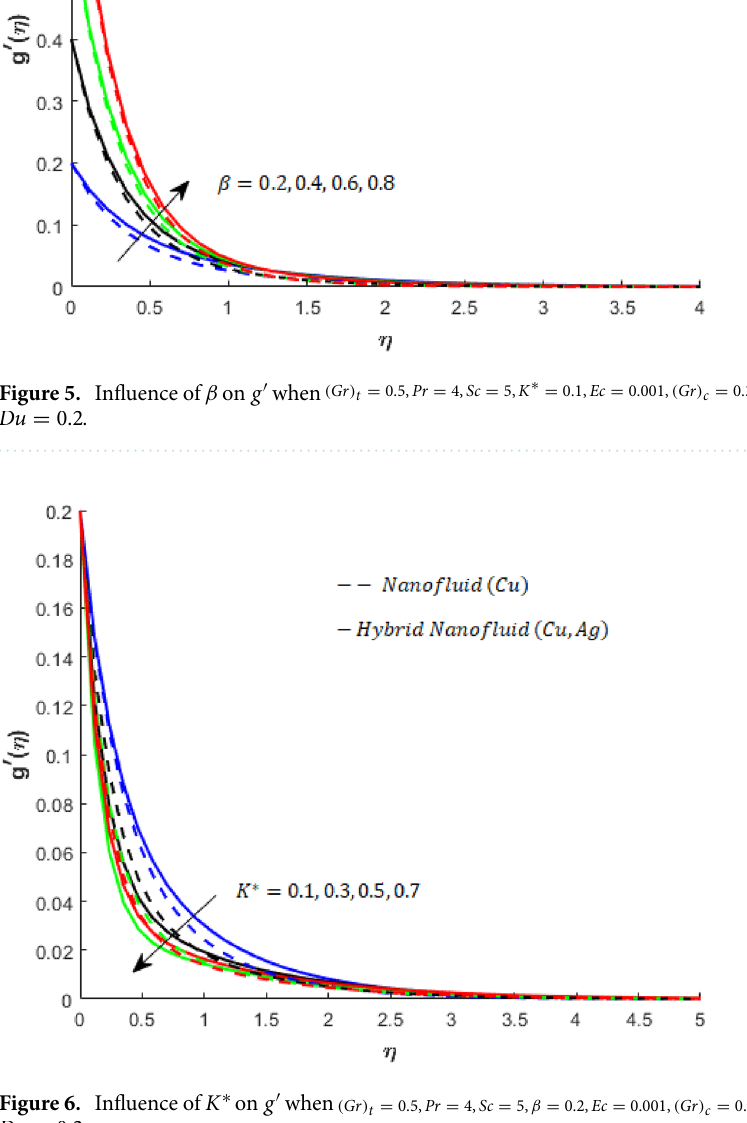
Figure 6. Influence of K ∗ on g ′ when ( Gr ) t Du =